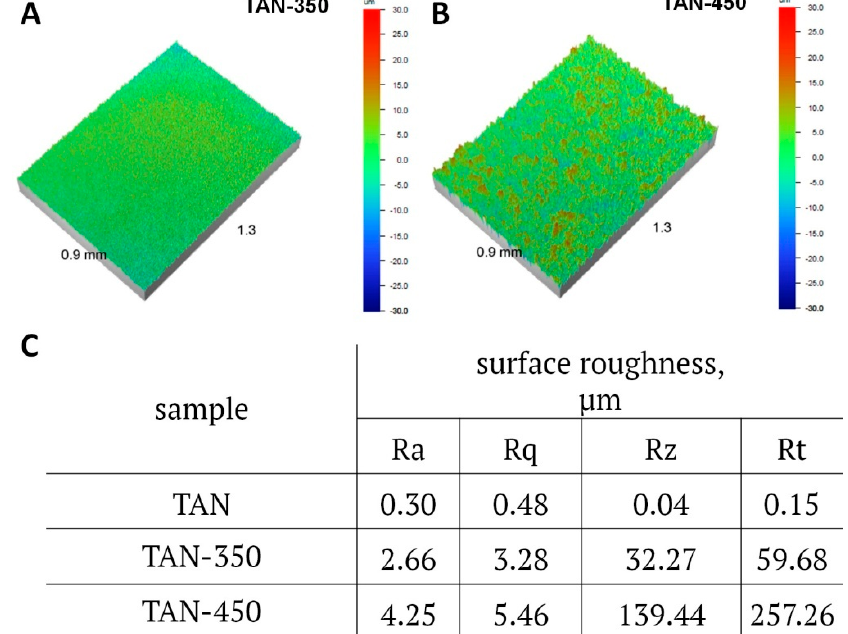
Figure 5. ( A , B ) Images of surface roughness of the samples measured from a selected area of the coatings (0.9 mm × 1.3 mm; magnification 5×), and ( C ) the results of the average measurements for each sample over selected areas of the coating surfaces.